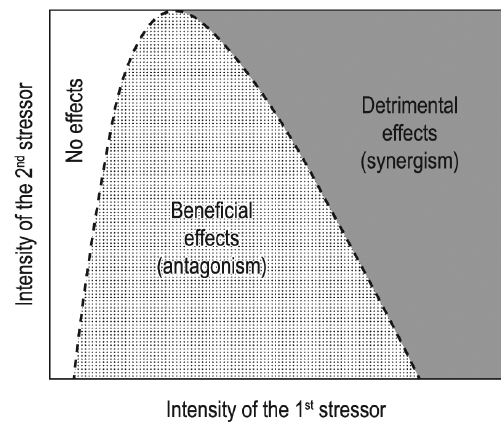
Figure 4. A conceptual model of the overall effects of exposure to two stressors sequentially and